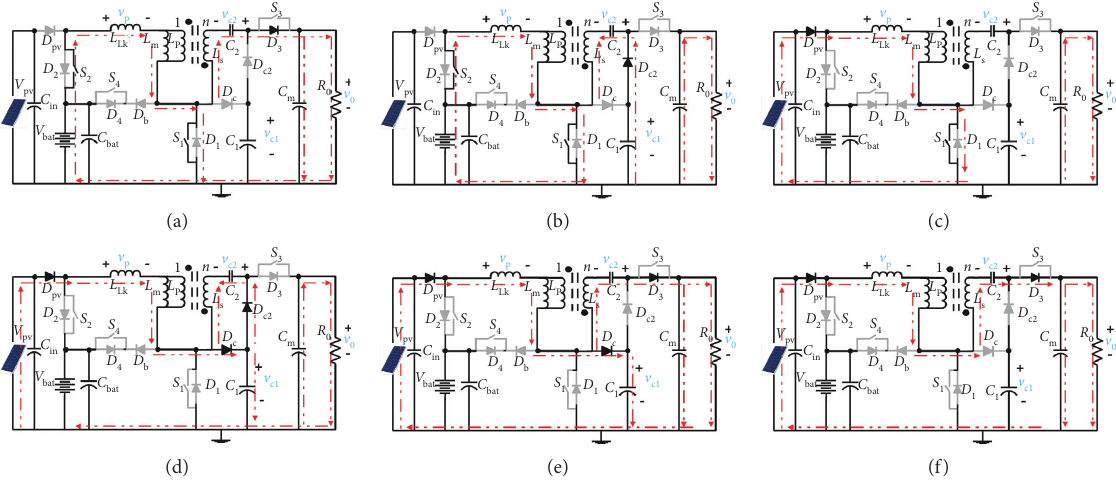
Figure 5: Steady-state equivalent circuits and current flow of the converter in DISO mode. (a) t ∼ t . (f) t ∼ t . (e) t 4 5 5 6